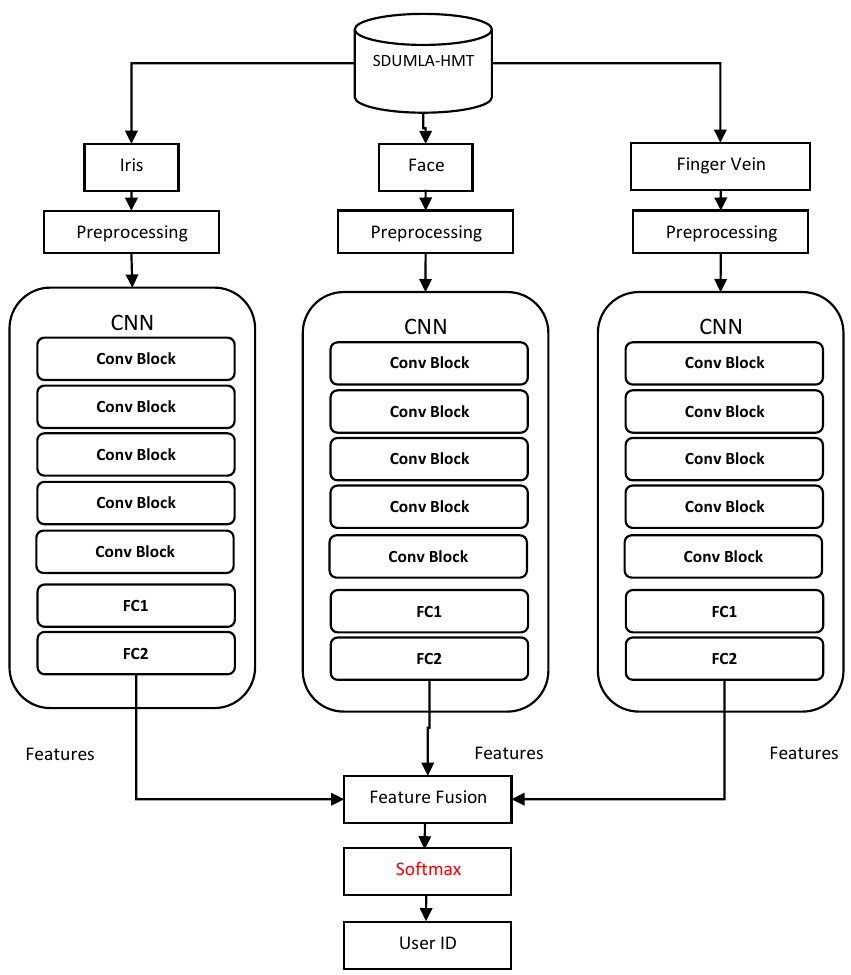
Figure 2. The framework of the multimodal biometric model using feature-level fusion approach. Conv Block represents a block of convolutional layers and pooling layers, and FC represents a fully connected layer.